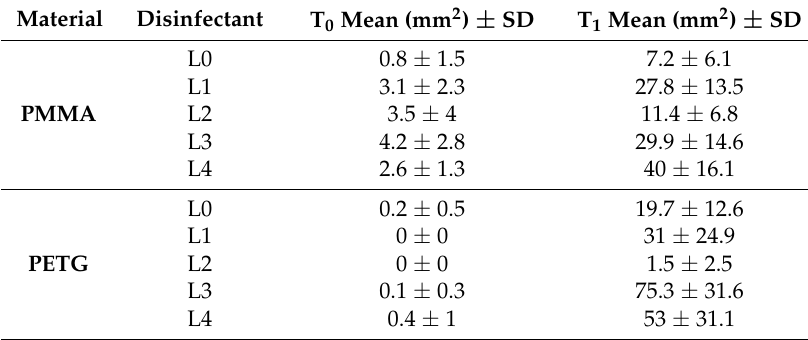
Table A3. Descriptive data for damaged chitosan coating area (DCSCA) at baseline T 0 and after disinfection/abrasion test T 1